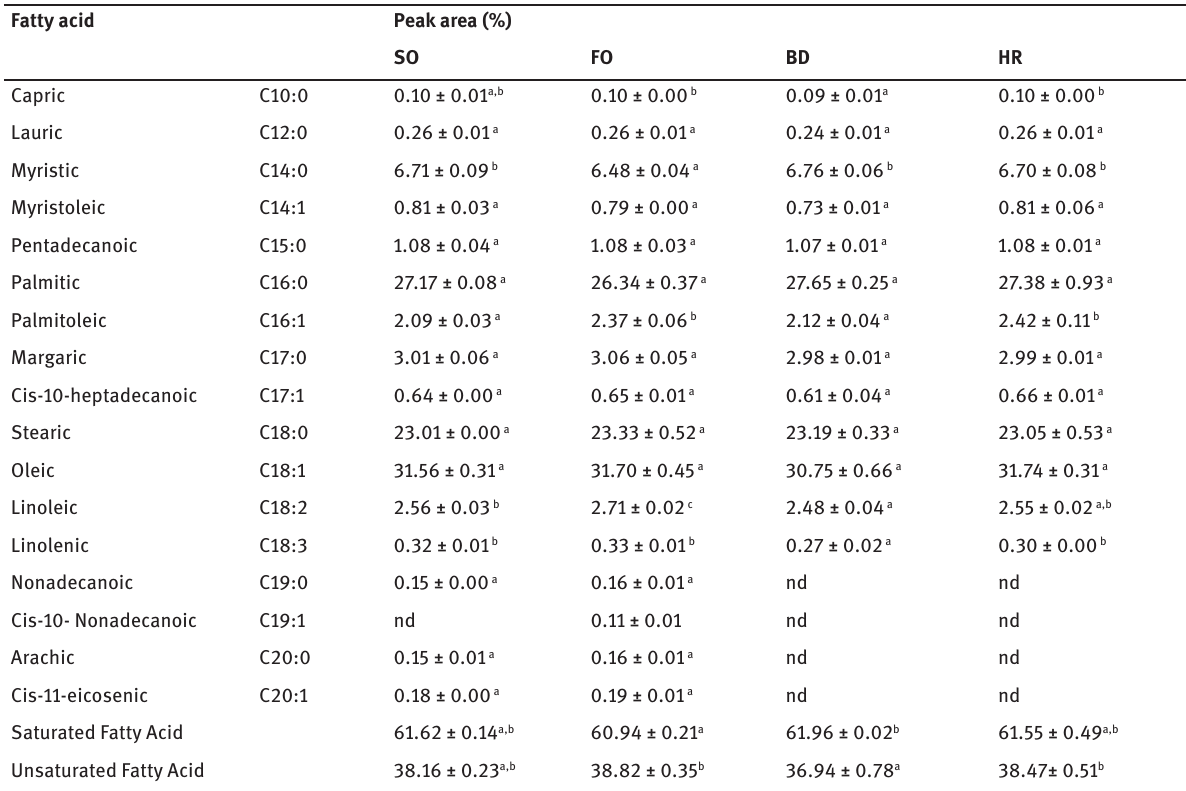
Table 2: Fatty acid composition of beef fat in four extraction methods using GC-MS. Fatty acid